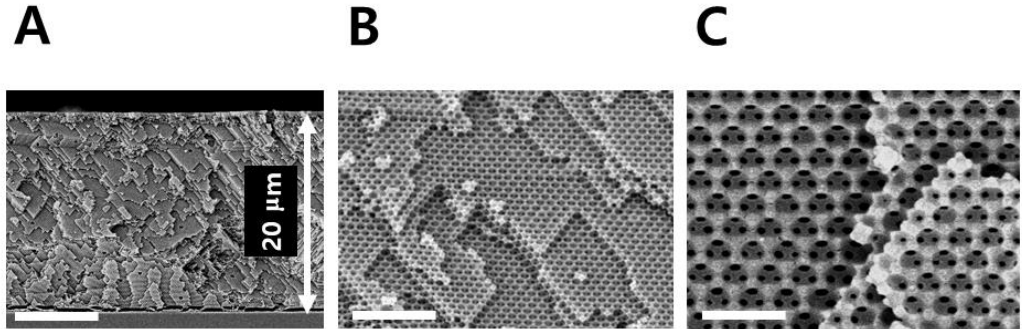
Figure 2. Scanning electron microscopic images showing the cross-sections of inverse opal structure of cross-linked PHEMA IOPG used in this study. Scale bars indicate 7 ( A ), 3 ( B ), and 1 μm ( C ) respectively.